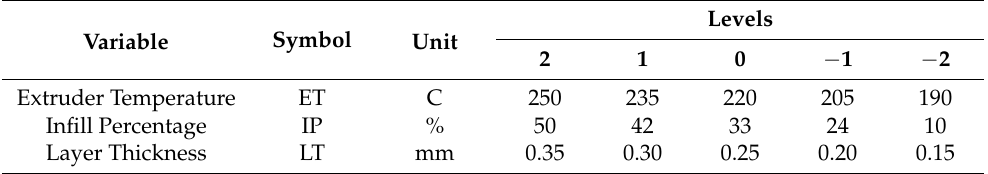
Figure 1. Levels of Central Composite Design for LT, ET, and IP ( − 2 to +2). A total of 20 initial experiments for printing 40 samples and three optimal samples were evaluated by considering three levels of the output response. Table 1 indicates the input levels of the printer parameters, and the DOE selects the experiment design based on the level of the input parameters. Table 1. Independent input parameters.